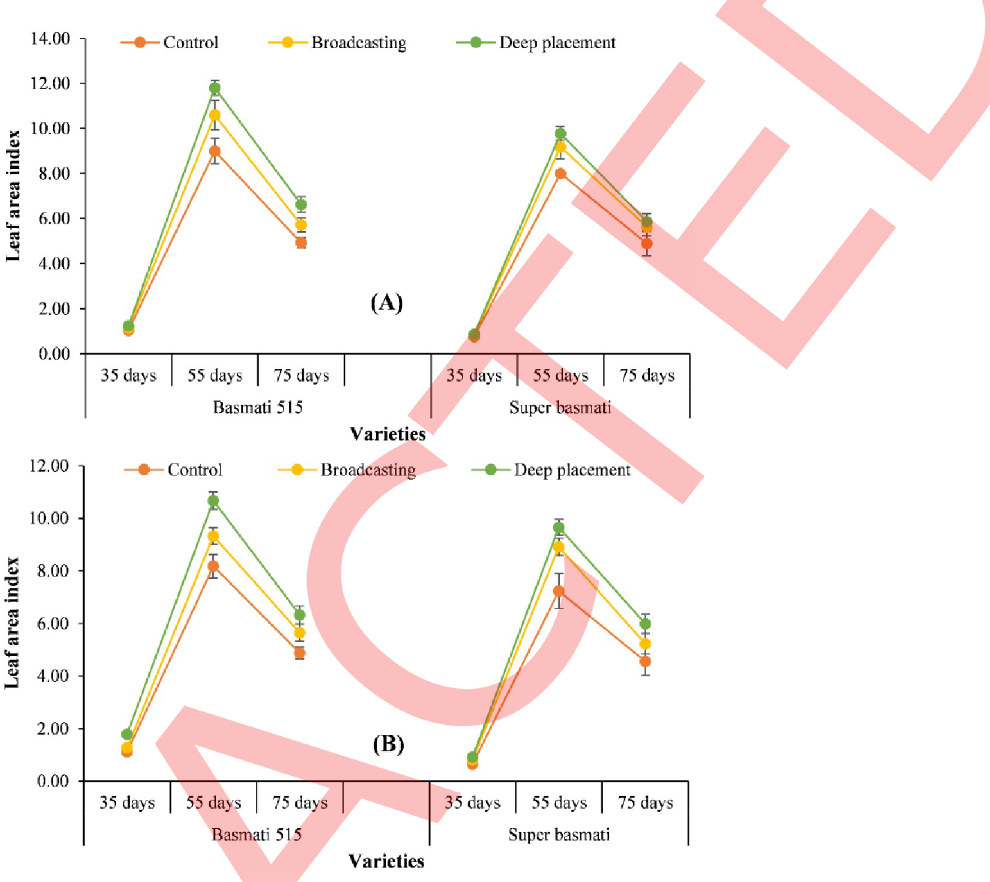
Fig 1. The impact of different nitrogen fertilizer application methods on leaf area index of transplanted fine rice during 2018 (A) and 2019 (B) the vertical bars represent standard errors of means (n = 4).